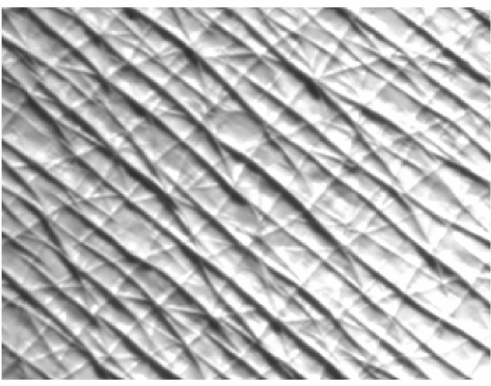
Figure 3. Visioline ® VL 650 image of mature skin; area: left forearm, inner